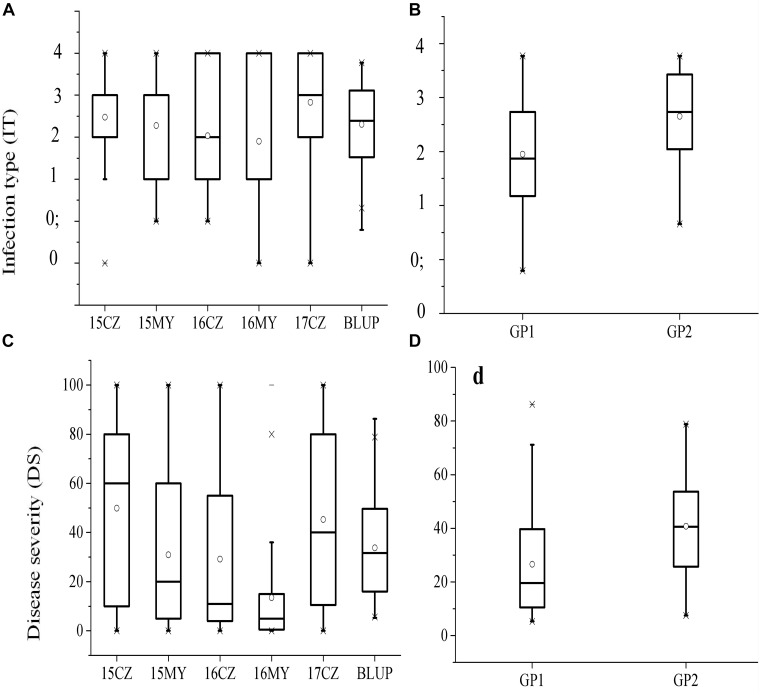
Box plot for distributions of IT (A) and DS (C) evaluated at the adult-plant stage in five environments; Mean, median, and range of IT (B) and DS (D) variation in each of the two subgroups at the adult-plant stage. Solid horizontal lines show medians. The circle signs the mean, the top and bottom box edges show the 25th to 75th percentiles of the total data, and the outer outliers.